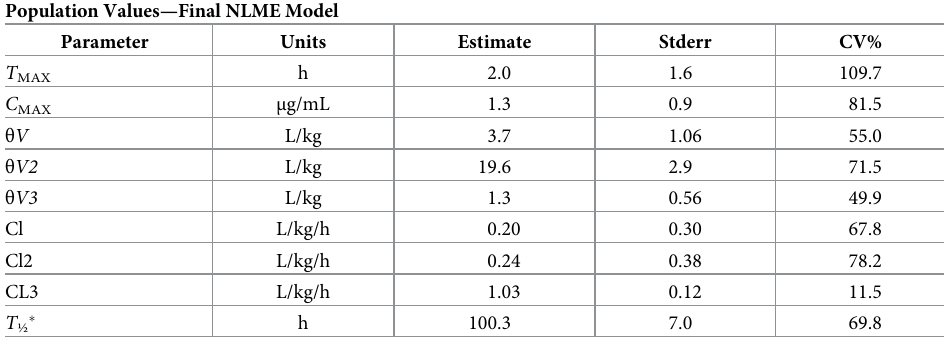
Table 4. Population pharmacokinetic parameters for tulathromycin in 3-week old vs. 6-month old calves with respiratory disease. Population Values—Final NLME Model Parameter Units Estimate Stderr CV% T MAX C MAX μ g/mL θ V L/kg 55.0 θ V2 L/kg 19.6 71.5 θ V3 L/kg 1.3 0.56 49.9 Cl L/kg/h 0.20 67.8 Cl2 78.2 CL3 L/kg/h 1.03 0.12 11.5 T ½ � h 100.3 69.8 Population values from NLME model and median and range of PK parameters from compartmental analysis after single S.C. injection of 2.5 mg/kg tulathromycin in 3-week-old vs. 6-month-old calves with induced respiratory disease with P . multocida . � Indicates significantly different by t -test ( P <